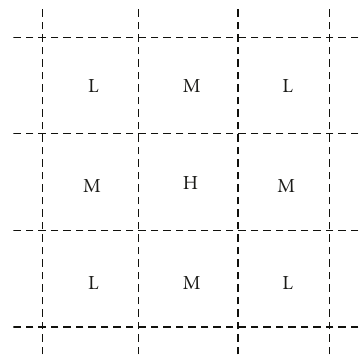
Figure 2: The tessellation scenario.